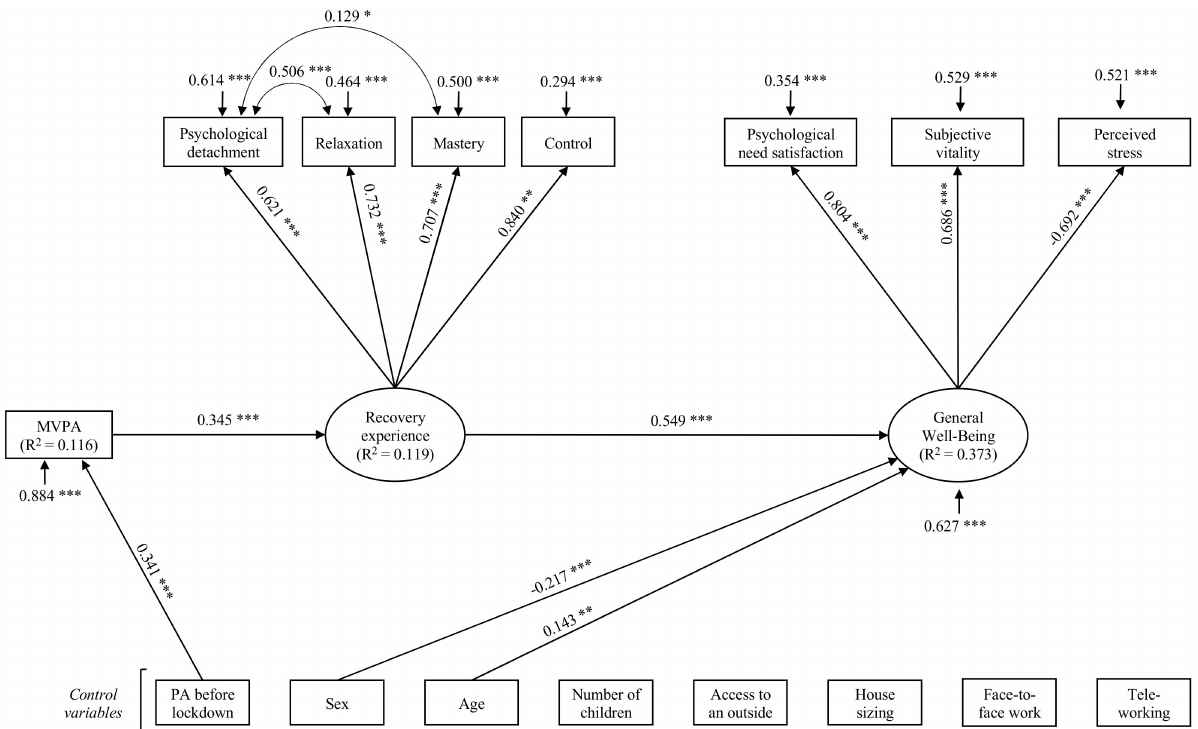
Figure 1. Structural equation modeling of the relations between physical activity, recovery experiences, and general well-being for all participants. Note. Completely standardized maximum likelihood parameter estimates. Solid lines indicate significant paths. Non-significant paths are not displayed. *** p < 0.001. ** p < 0.01. * p <